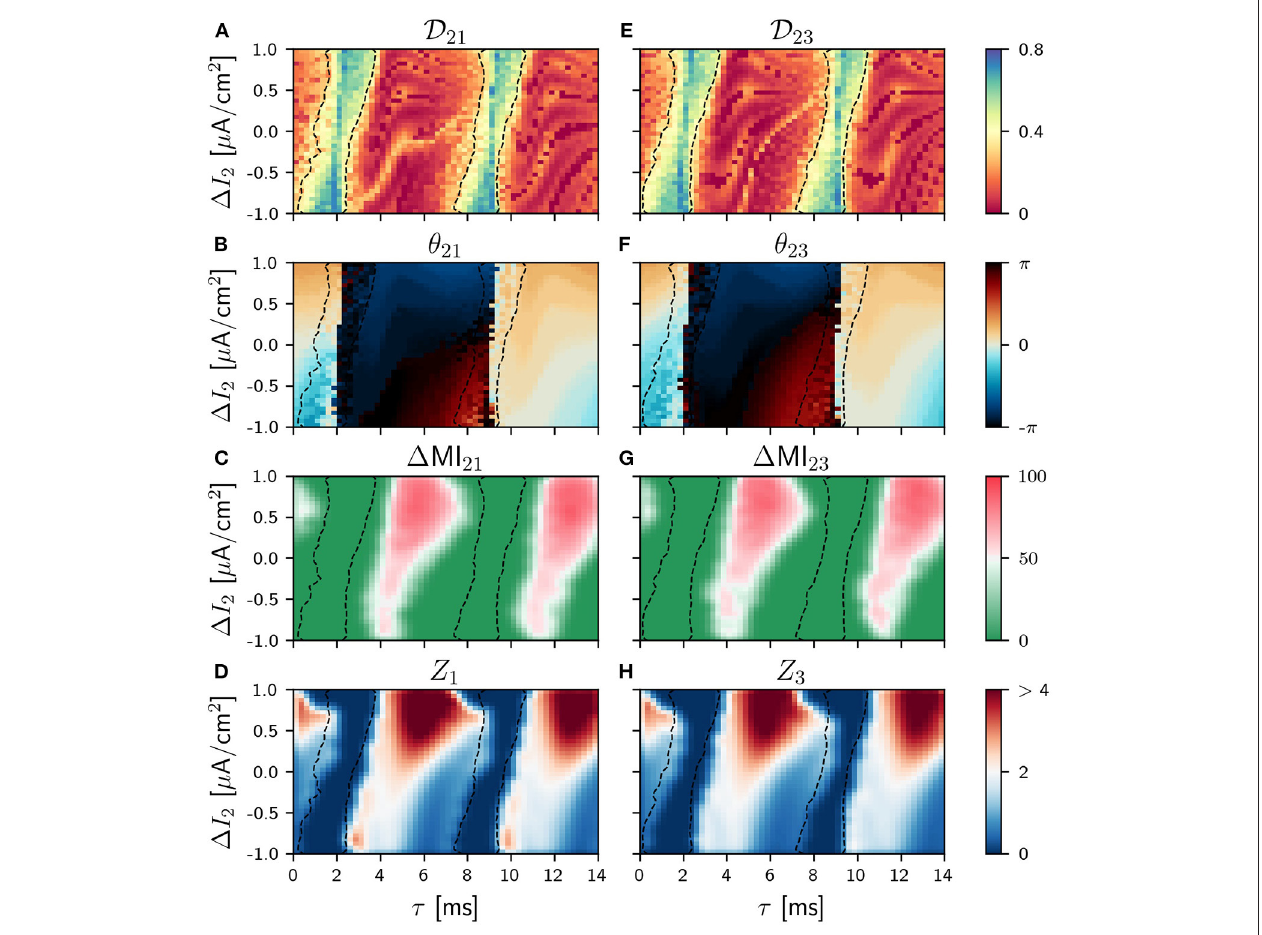
FIGURE 4 | Population 2 as the sender in the V-motif. Phase locking index D ij (A,E) . Phase difference θ ij (B,F) . Difference 1 MI ij (C,G) when a slow modulation is injected. Integral of the absolute value of the nPRC Z i (D,H) when a fast signal is injected. All of them as a function of the delay and the frequency mismatch 1 I in population